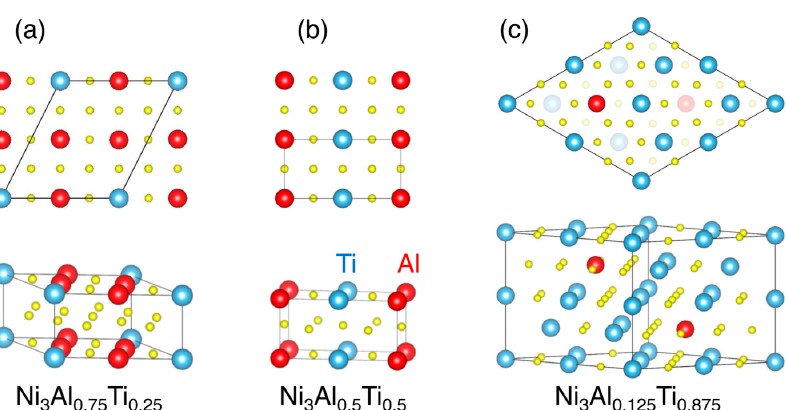
Figure 2. The ground-state candidates: L1 2 -based orthorhombic structures at ( a ) x = 1/4 and ( b ) x = 1/2; ( c ) D0 24 -based hexagonal structure at x =7/8. Ti is light blue; Al is red; Ni is small yellow. There are multiple structures with well-spaced Al solute on the GS hull at x > 0.875, see text.